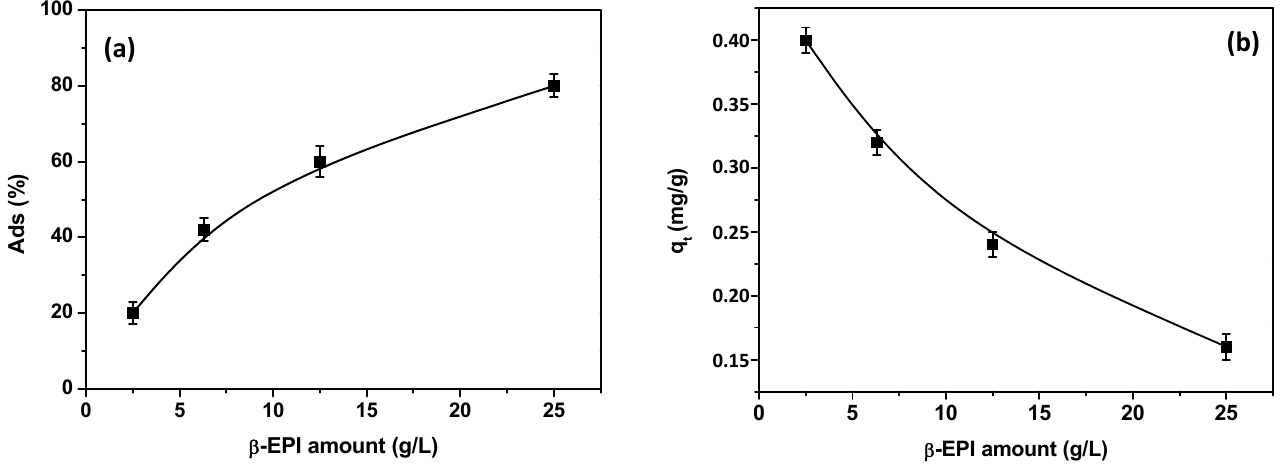
Figure 2. Dependence of the CBZ (5 mg/L) adsorption percentage ( a ) and q t , the adsorbed mass in mg of CBZ on adsorbent mass in g ( b ) at the equilibrium as a function of the polymer dose. Analyzing the same data in the form of q t , the adsorption capacity, vs. polymer dose in Figure 2b, this parameter decreases when using higher quantities of polymer. This sug ‐ gests that, when using a large amount of adsorbent, the adsorption sites remained par ‐ tially unsaturated during the adsorption process, reducing the q t values as a whole.